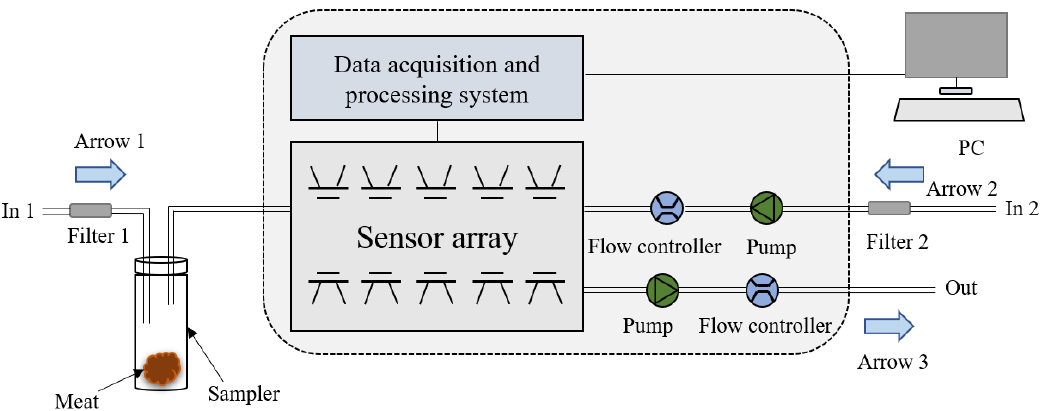
Figure 1. Schematic diagram of data collection using an